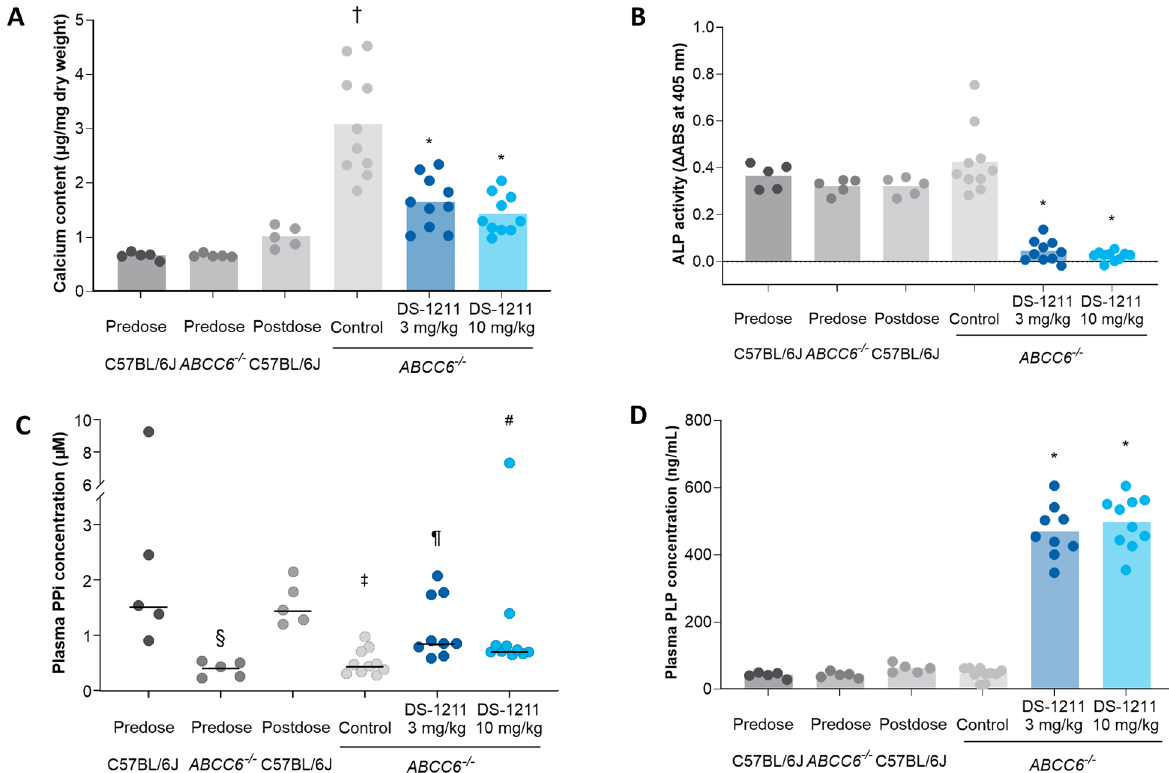
Figure 2. Calcium content (mean) ( A ), plasma ALP activity (mean) ( B ), plasma PPi concentration (median) ( C ), and plasma PLP concentration (mean) ( D ) in ABCC6 -/- and C57BL/6J mice before and after DS-1211 administration. * P < 0.0001 versus ABCC6 -/ - control group; † P = 0.0005 versus postdose C57BL/6J control group; § P < 0.01 versus C57BL/6J predose control group; ‡ P < 0.001 versus C57BL/6J control group; ¶ P < 0.01 versus ABCC6 -/- control group; # P < 0.05 versus ABCC6 -/- control group. ABS, absorbance; ALP, alkaline phosphatase; PLP, pyridoxal-phosphate; PPi, pyrophosphate.